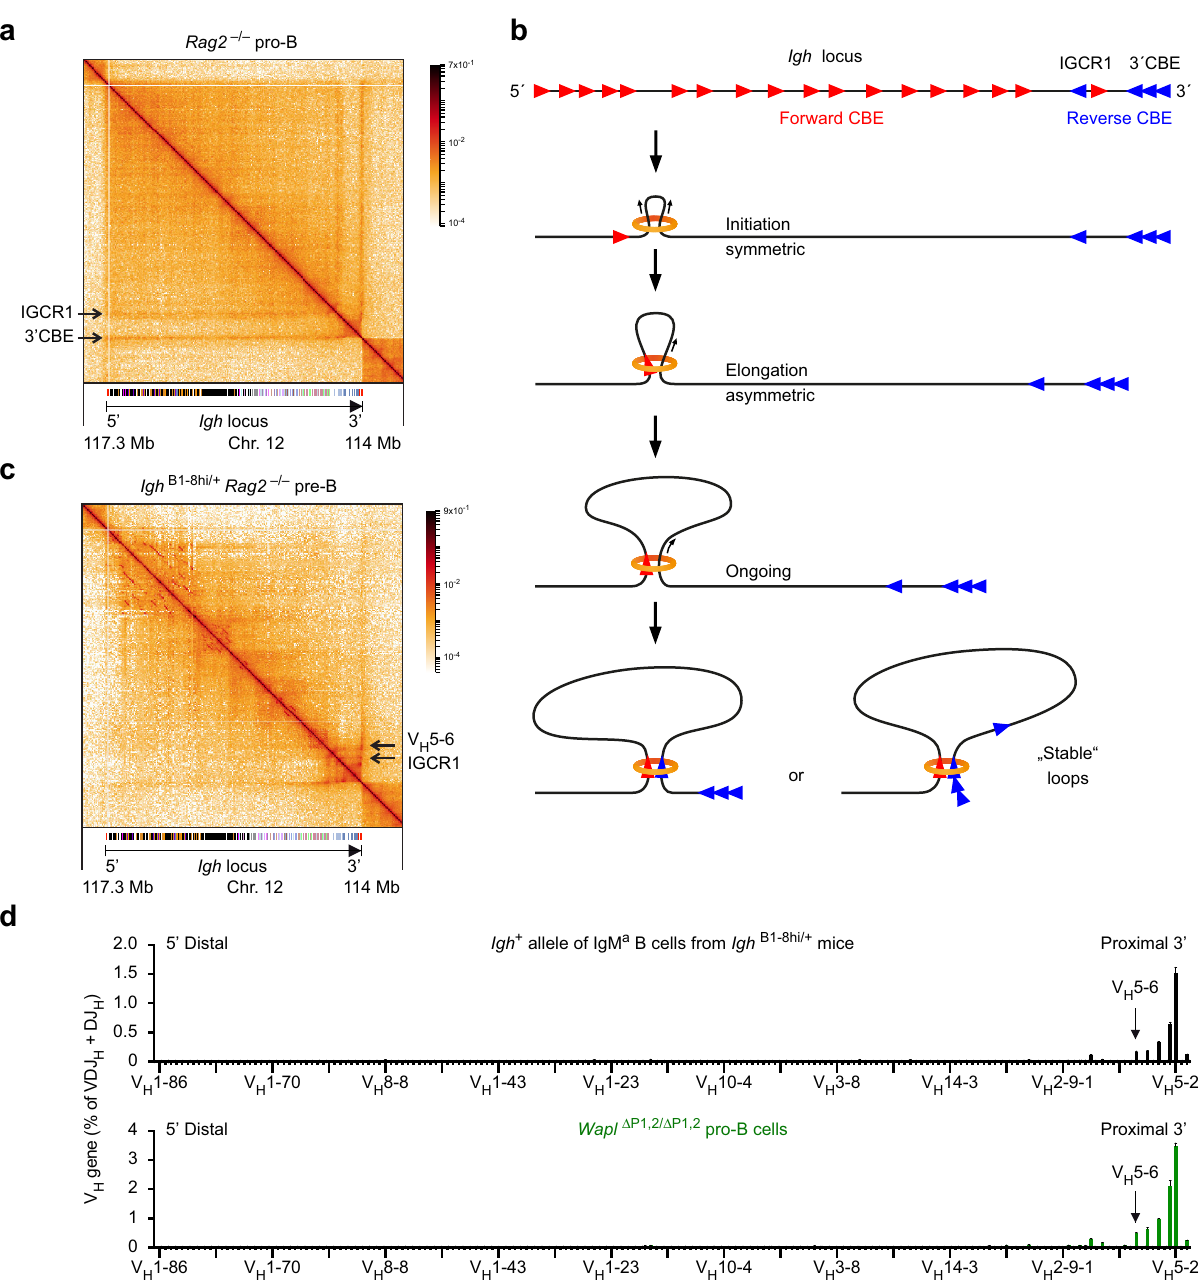
reverse CBE in convergent orientation at the IGCR1 or 3 ’ CBE elements 5 . c Contact matrix of the Igh region in ex vivo sorted Igh B1-8hi/+ Rag2 – / – pre-B cells. See a for an explanation. The position of the IGCR1 element is indicated together with the location of the V H 5-6 gene. d Upper part : VDJ-seq data obtained with